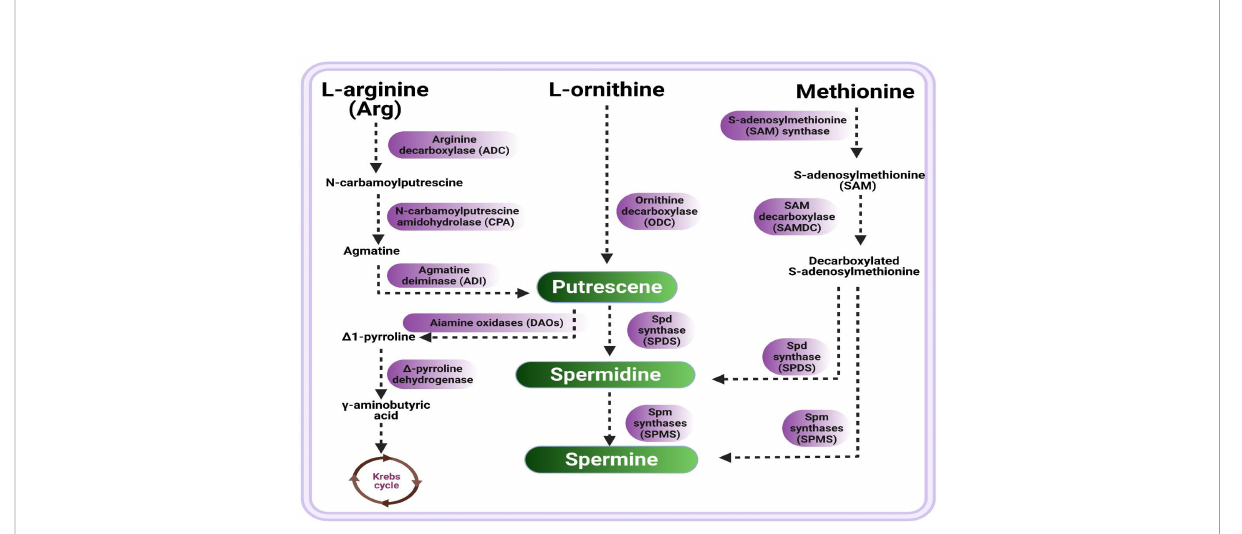
FIGURE 1 Schematic presentation of polyamines biosynthetic pathway. There are three routes of putrescine synthesis from arginine (route 1), ornithine (route 2), and methionine (route 3) followed by multiple sequential steps, resultant putrescine converts into spermidine which in turn produce